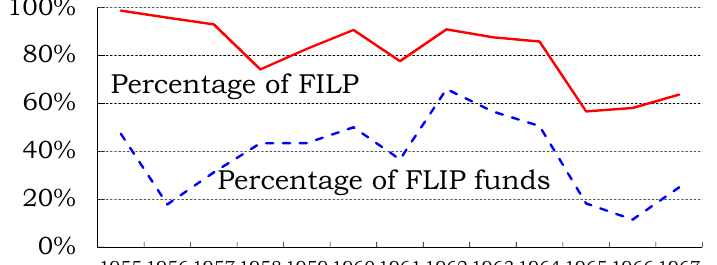
Figure 1. Percentage of FILP to JNR’s capital expenditure (in fiscal years) Source: Takahashi (2000, Figure